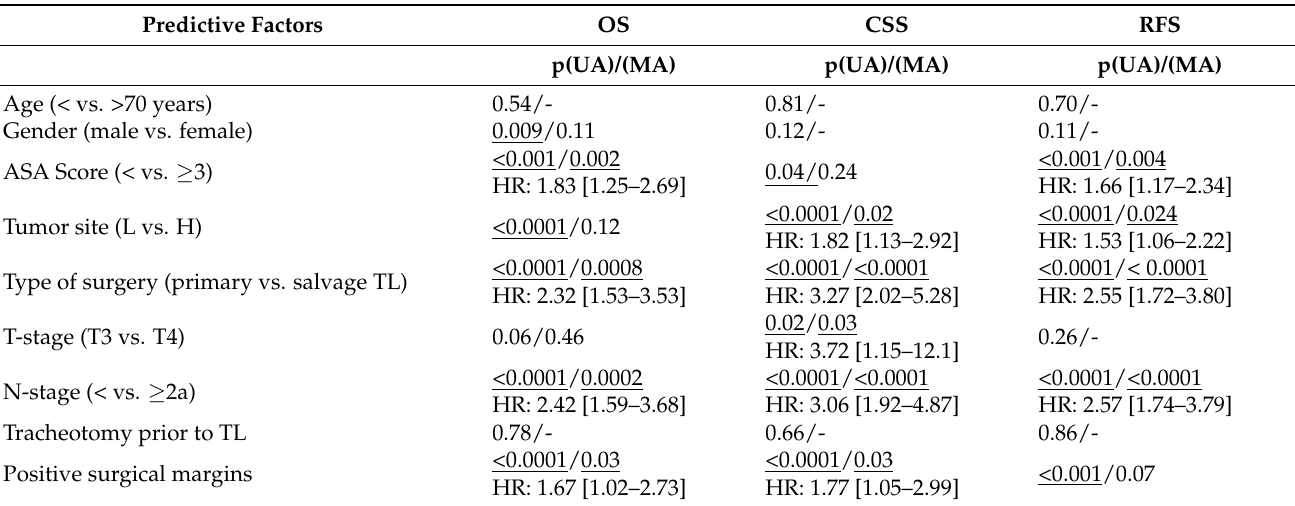
Table 3. Predictors of oncologic outcomes in univariate and multivariate